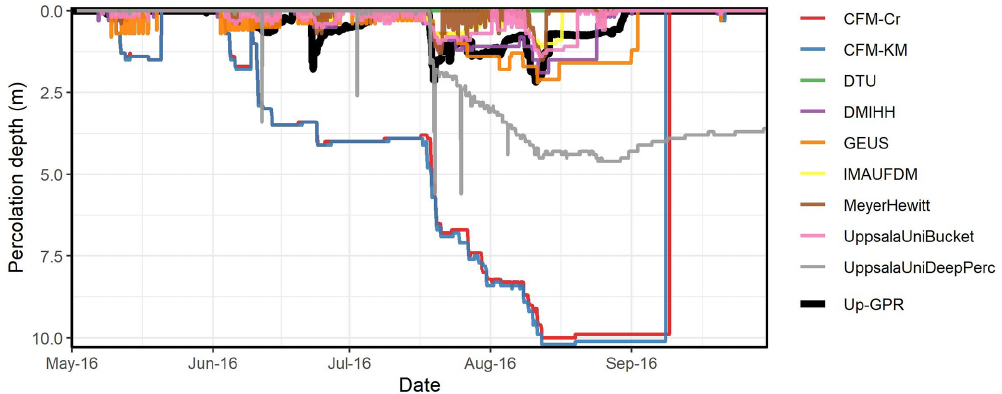
Figure 7. Comparison of the simulated (colored lines) and upGPR-derived (black line) meltwater percolation depth at Dye-2 over the 2016 melting